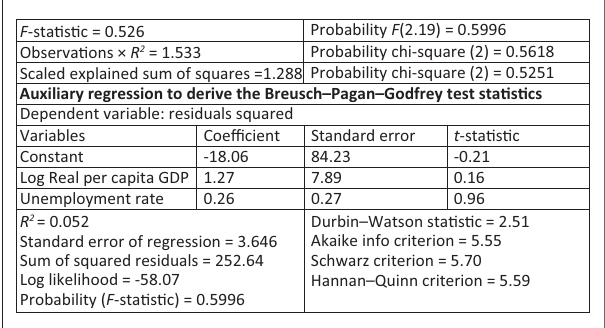
FIGURE 2-A1: Correlogram: serial correlation test.